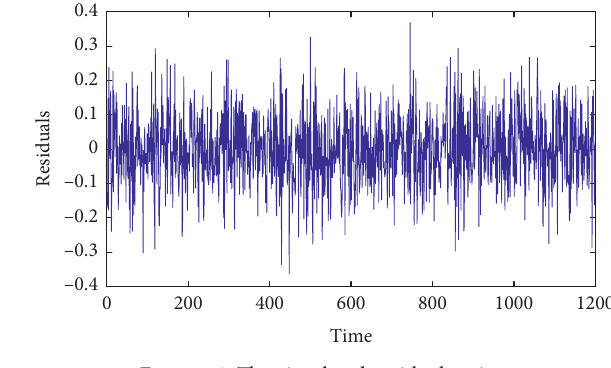
Figure 6: The simulated residual series.